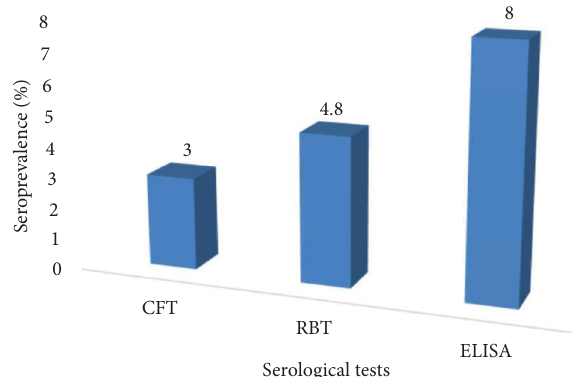
Figure 2: Te overall seroprevalence of Brucella infection (%) in Dhofar using CFT, RBT, and Table 1: Univariate analysis for the association of the risk factors with Brucella seroprevalence using the I-ELISA. I-ELISA Risk factors No. Chi-square p value Positive (%) Negative (%)